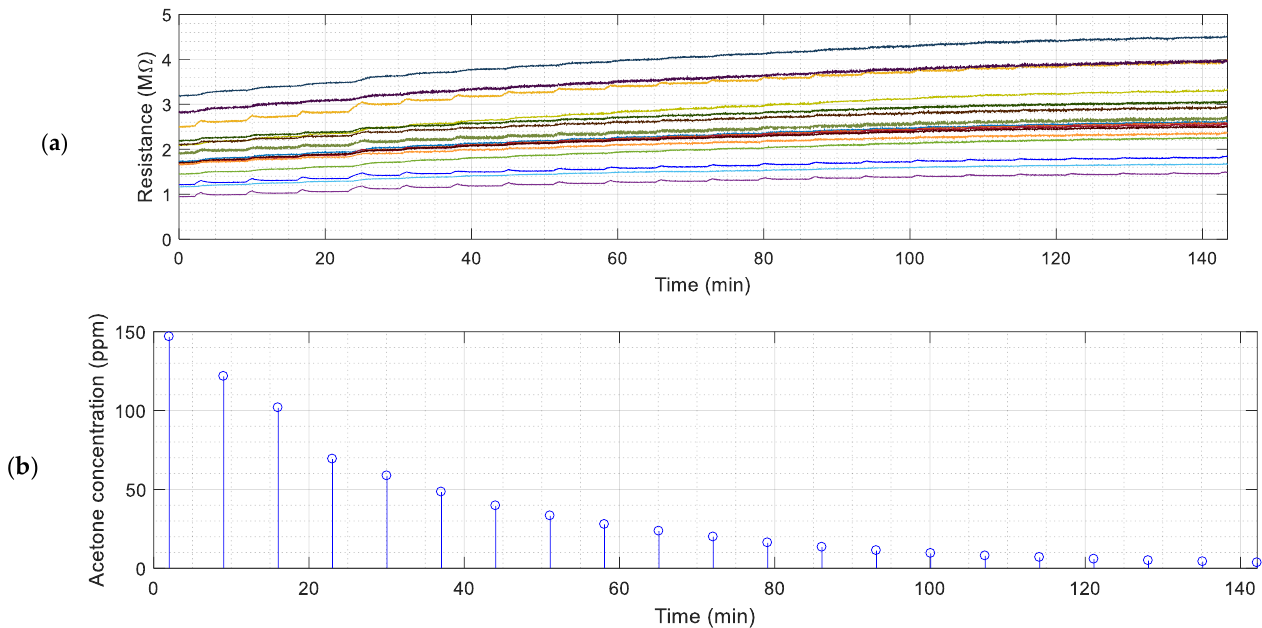
Figure 4. Results of an eNose calibration experiment with acetone: ( a ) evolution of resistance of the sensing layer of the 16 MOX gas sensors embedded in the 16 BME680 sensors, and ( b ) reference acetone concentration measured with the PID (assumed as the ground truth concentration).